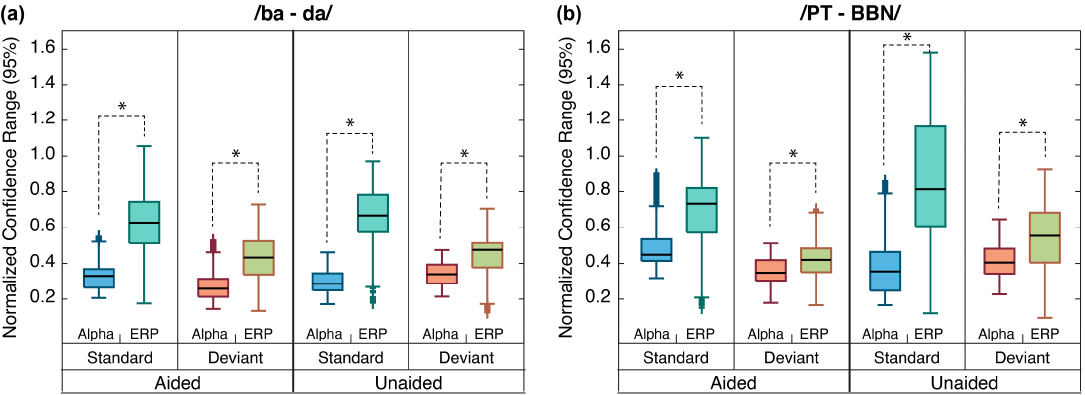
Figure 6. Alpha band vs. ERP variability. Boxplots represent the range of the 95% confidence intervals for each group-averaged response for each stimulus contrast: ( a ) /ba-da/ and ( b ) /PT-BBN/. Boxes in each panel are grouped according to each Alpha vs. ERP comparison for the standard and deviant responses and for the aided and unaided responses. The asterisk (*) above each comparison set indicates a significant difference ( p < 0.001, FDR corrected).